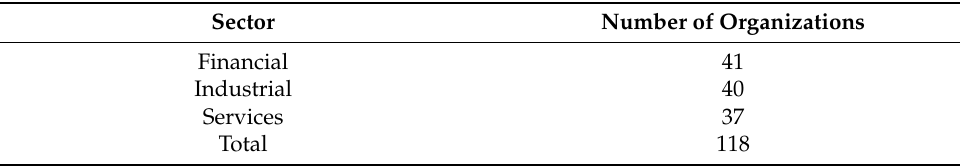
Table 1. Organizations Listed in Muscat Stock